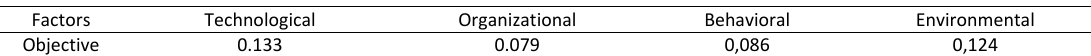
Table 6: Limited Super matrix Result